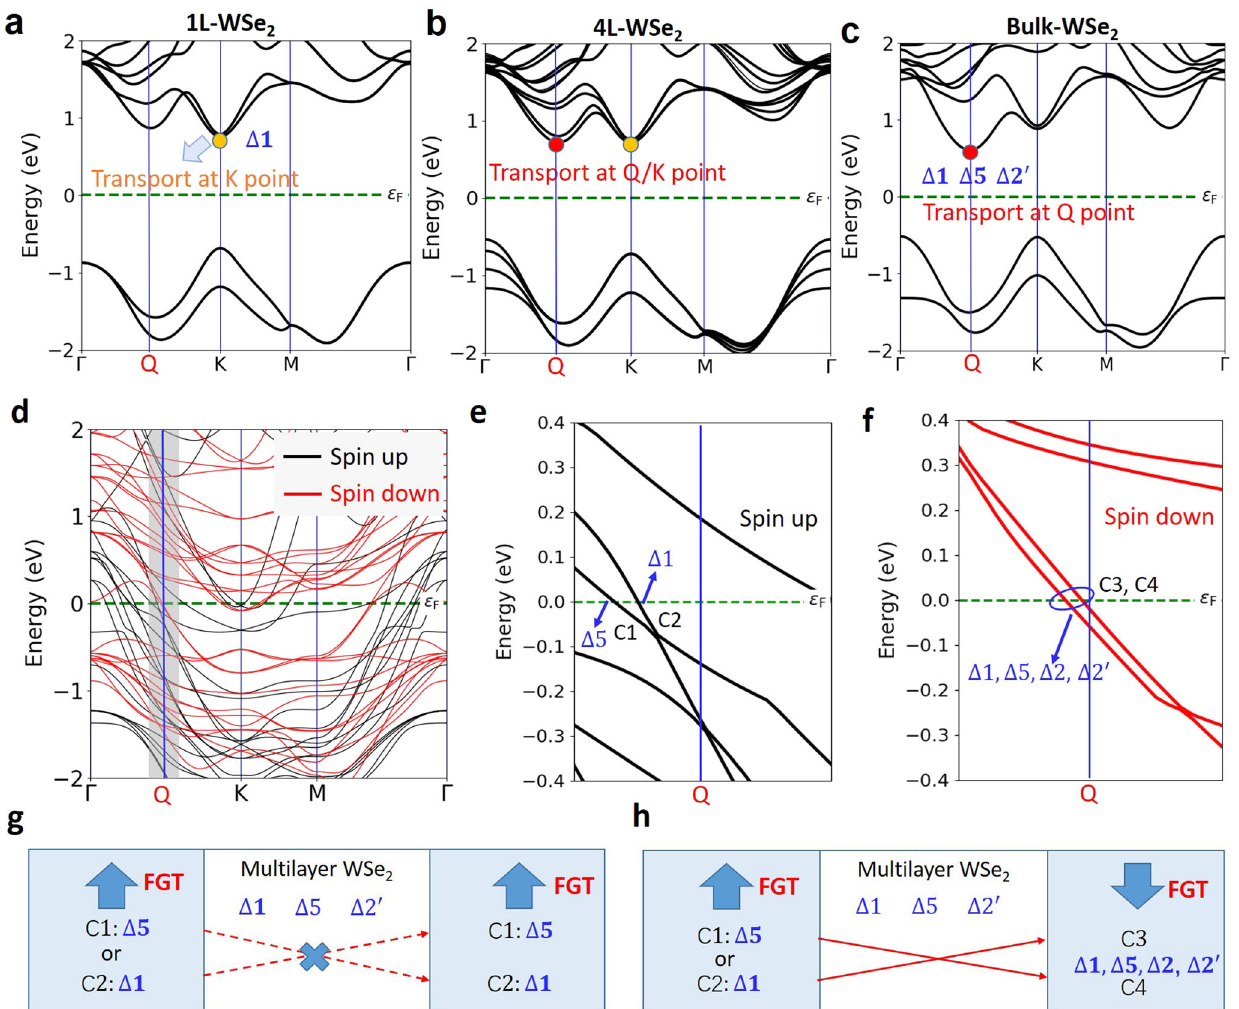
Fig. 6 Spin-related transport model based on ab initio calculation. a Band structure of monolayer. b Band structure of four layers. c Band structure of bulk WSe 2 . d Spin-dependent band structure of bulk FGT. e Band structures of FGT near the Q-point for the spin-up bands. f Band structures of FGT near the Q-point for the spin-down bands. Black and red lines represent the spin-up and spin-down bands, respectively. g The model of symmetry-state selection for the tunnel current in P state of FGT/WSe 2 /FGT system. h The model of symmetry-state selection for the tunnel current in AP state of FGT/WSe 2 /FGT